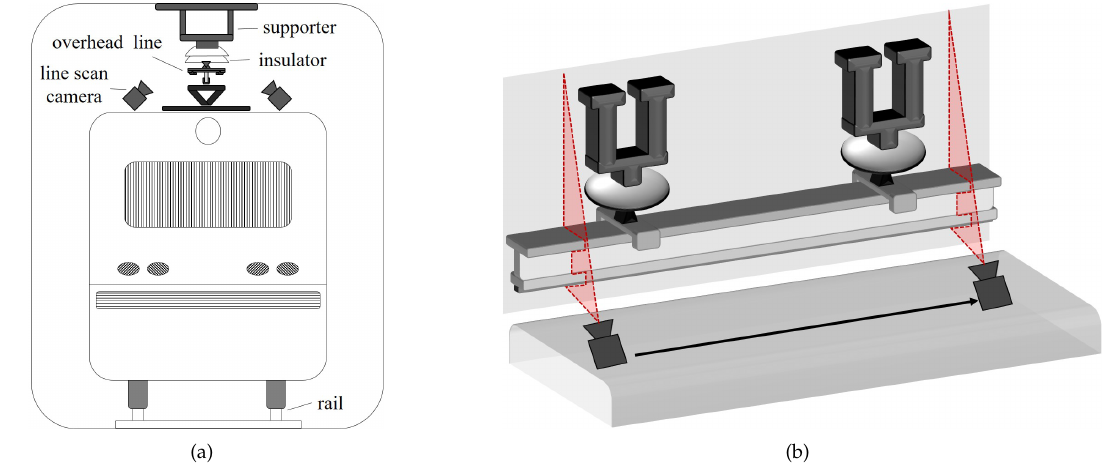
Figure 1. ( a ) Front view of a railroad vehicle in an underground tunnel and ( b ) image acquisition process using a line scan camera.